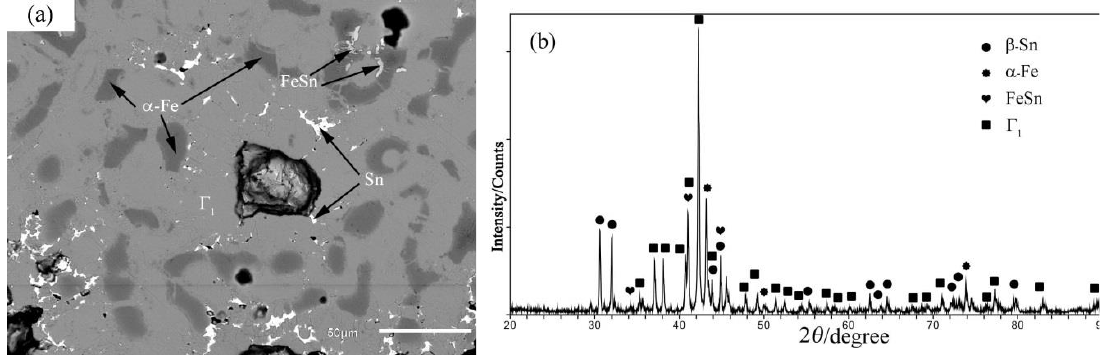
Figure 9. The microstructure ( a ) and XRD pattern ( b ) of Alloy A13.